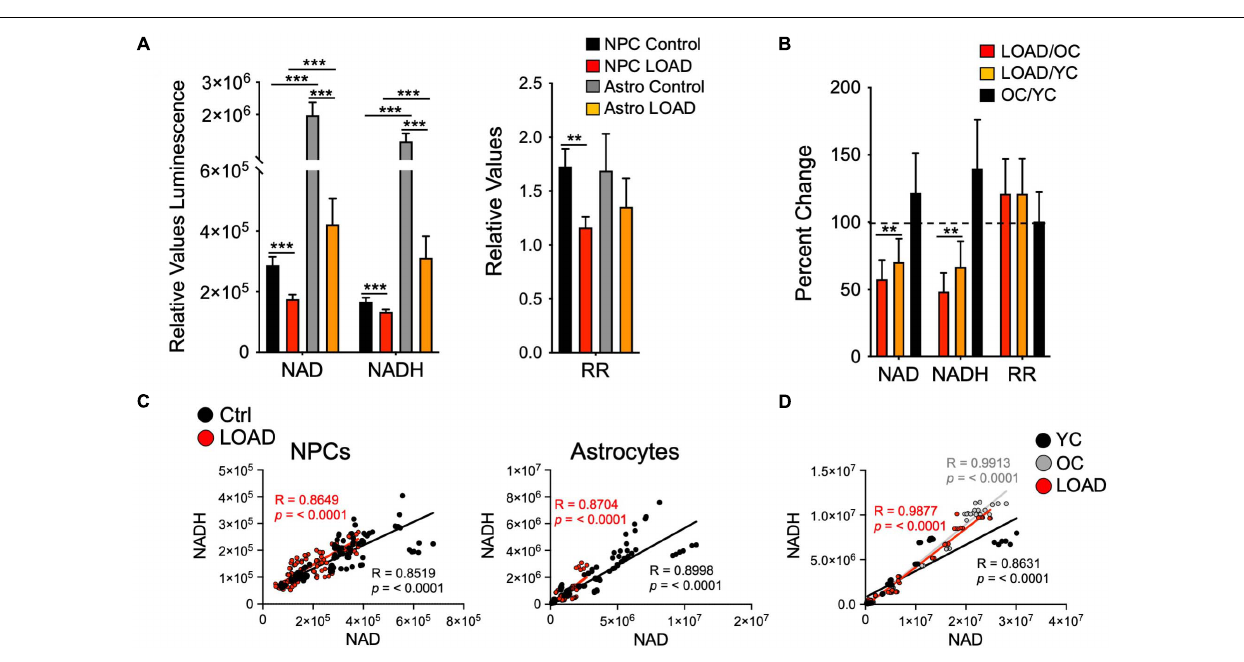
FIGURE 3 | NAD + and NADH production in iPSC-derived NPCs and astrocytes, and fibroblasts. (A,B) Relative NAD + and NADH levels measured as luminescence and RR of LOAD ( n = 9, red bars) or Control ( n = 9, black bars) NPCs, and LOAD ( n = 9, orange bars) or Control ( n = 9, gray bars) astrocytes (A) , or as percent change LOAD/OC, LOAD/YC, and OC/YC from n = 16 YC, n = 14 OC, and n = 11 LOAD fibroblasts (B) . The average ages for fibroblasts are YC 26.5 ± 7.1, OC 67 ± 8.8, and LOAD 69 ± 9.7. (C,D) Pearson’s correlation coefficients for NAD + and NADH. Linear correlations for Control and LOAD NPCs and astrocytes (C) , and fibroblasts (D) for NAD + and NADH, plotted as relative values luminescence. R and p values are indicated. Data are means +/– SEM from 2 to 4 repeat experiments. * p < 0.1; ** p < 0.05; *** p < 0.01 using one-way